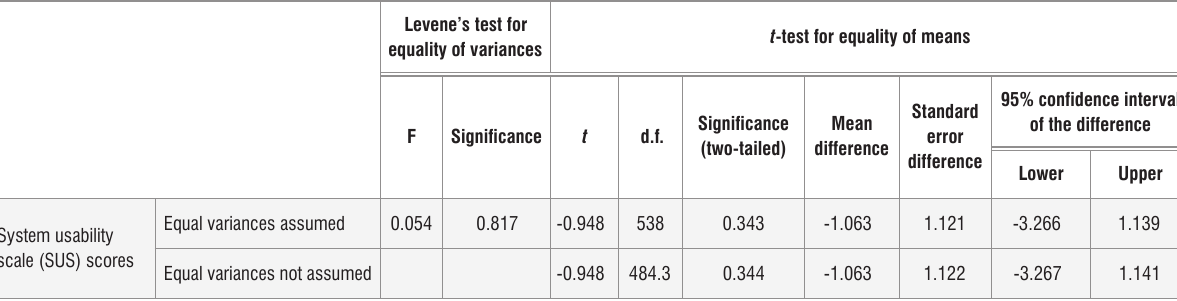
Table 3: Independent samples test: Gender